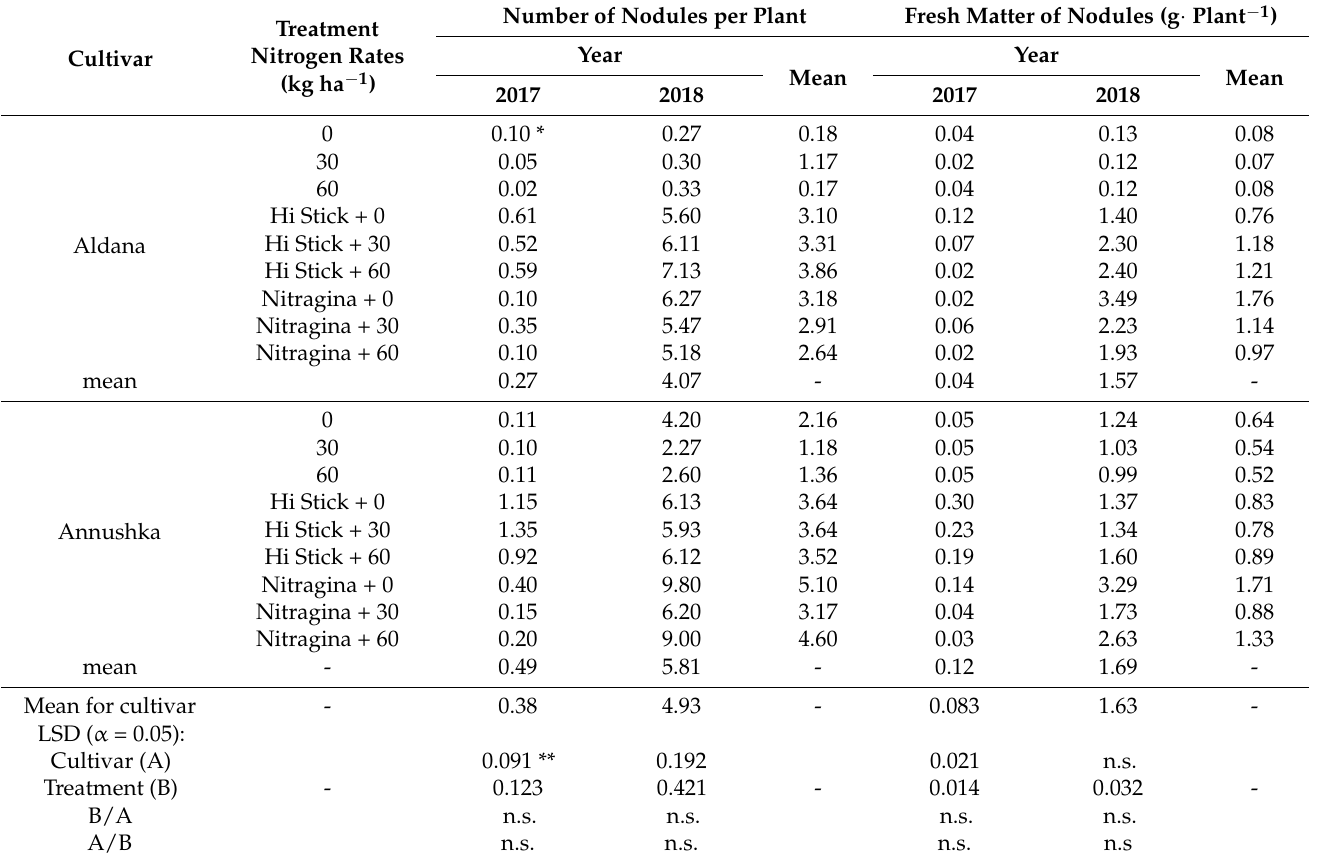
* Mean ± standard error. Table 6. Number and fresh matter of nodules per plant depending on the mineral N fertilization applied and the